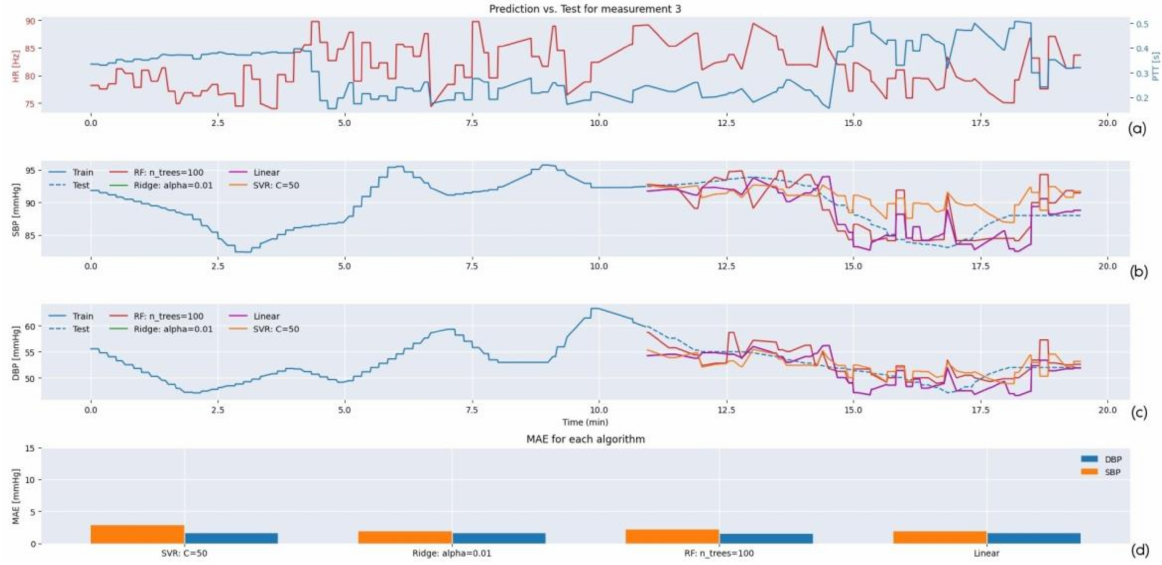
Figure 17. Training phase and test phase of the algorithms for signals from the SHIMMER database: ( a ) interpolation of the input values, ( b , c ) results of regression, and ( d ) MAE values for the se- lected